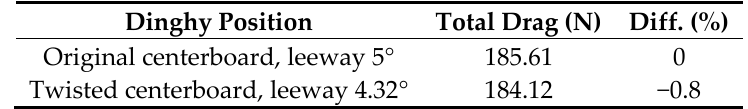
Table 3. Total reduced